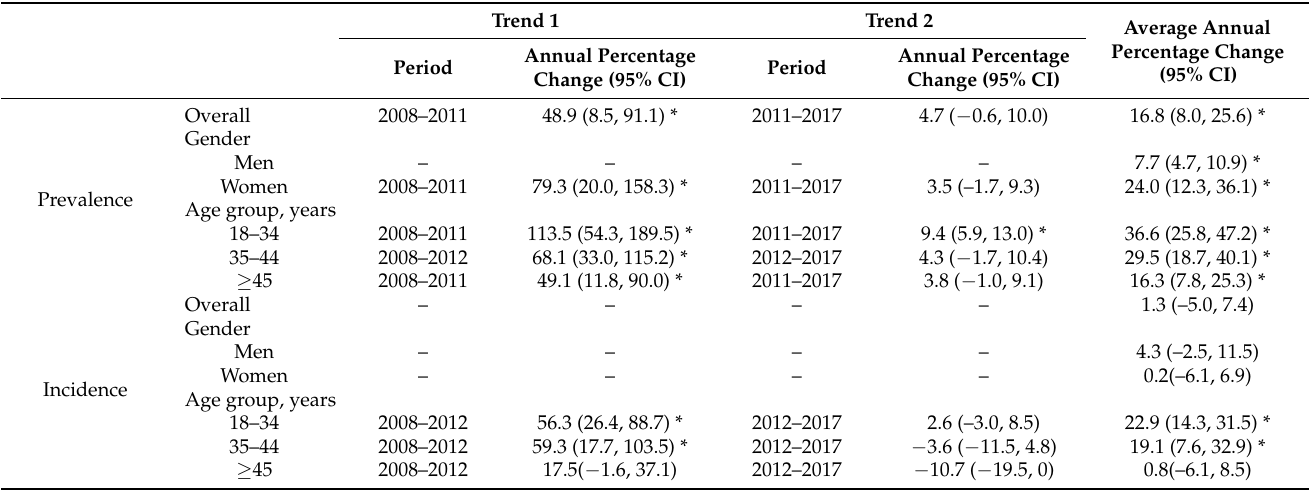
Table 3. Changes in the age-standardized prevalence and incidence of diagnosed knee osteoarthritis in Beijing, China, 2008–2017